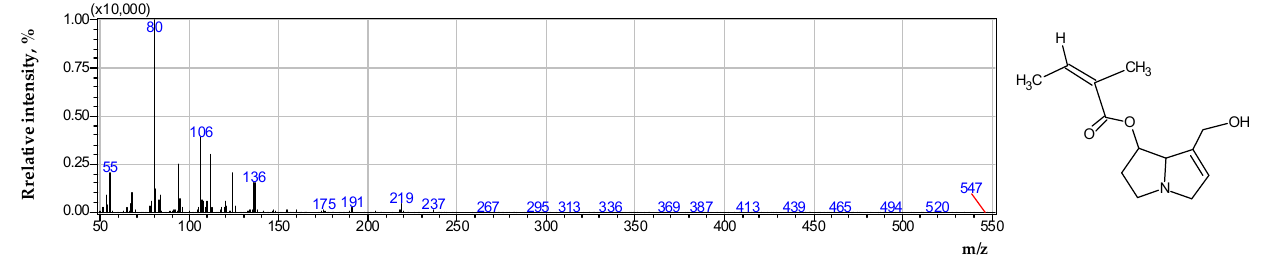
Figure 4. Mass spectrum at the top of the chromatographic peak at 5.547 min, corresponding to 7-Angeloylheliotridine extracted from Symphytum officinale (reference mass ions [M + H] + m/z 136 and m/z 124.03).